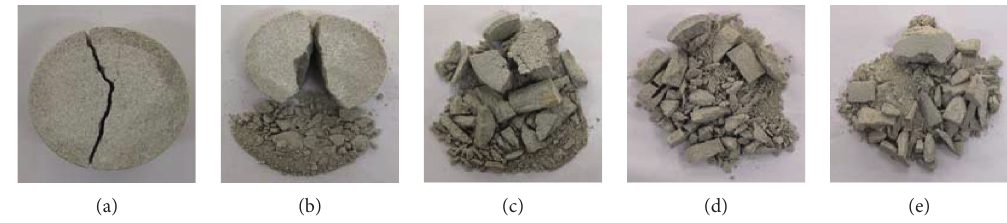
Figure 5: Fractured shape of damaged sandstone under impact load: (a) 0, (b) 20%, (c) 40%, (d) 60%, and (e) 80%. Table 2: Size distribution of broken rock blocks of sandstone with different damage degrees under impact load. Upper limit of stress